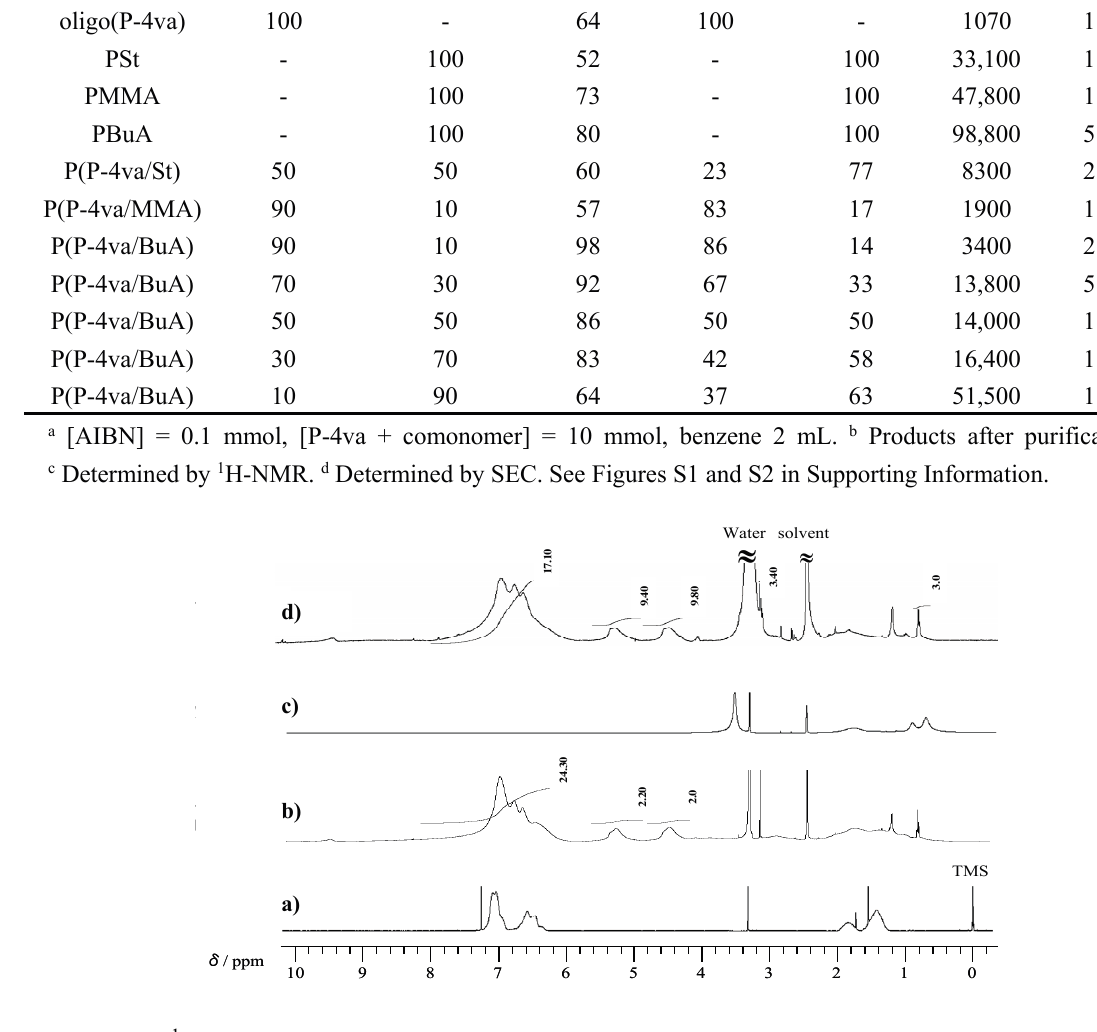
Figure 5. 1 H-NMR spectra of PSt (a), P(P-4va/St) (b), PMMA (c), and P(P-4va/MMA)